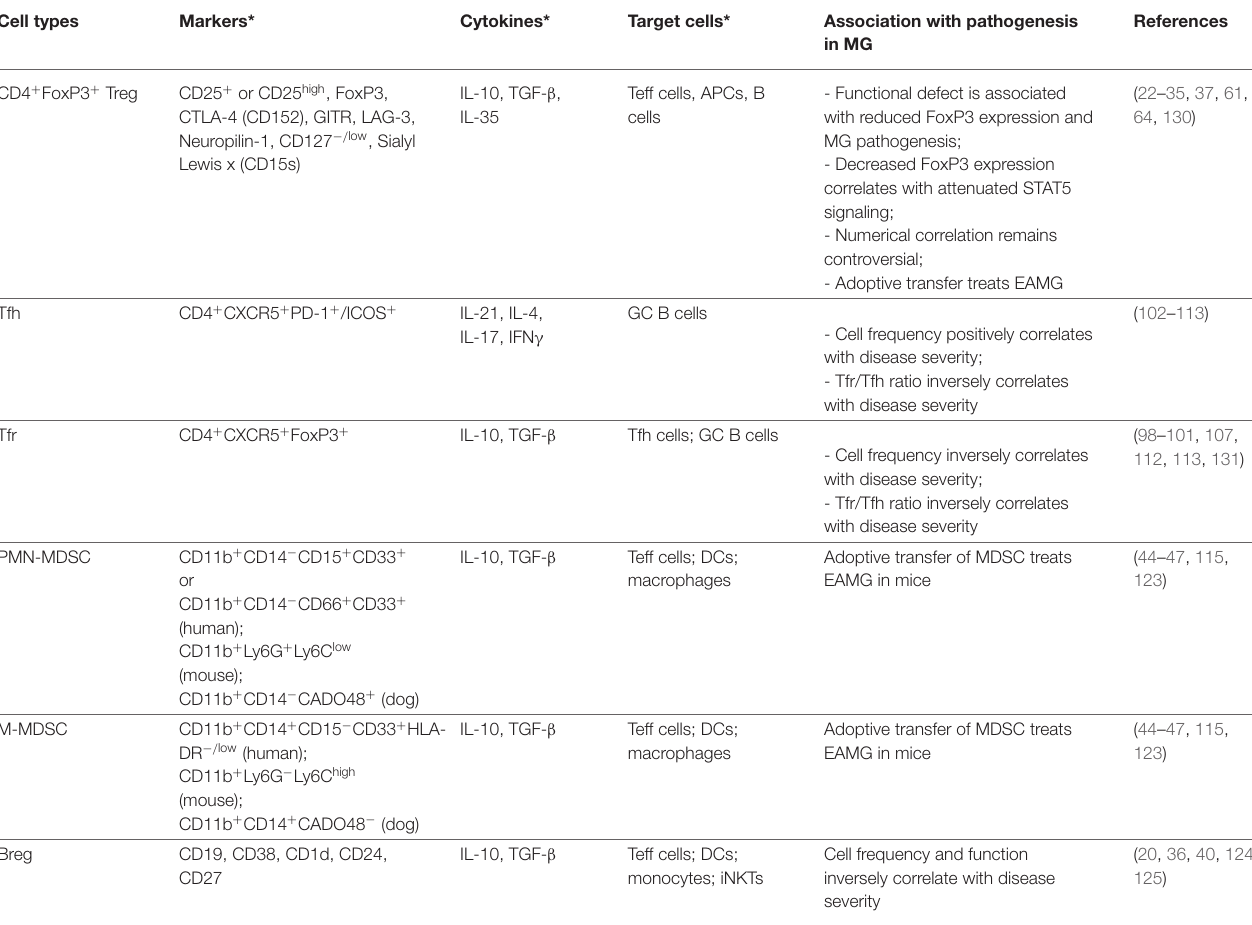
TABLE 1 | Summary of Immunoregulatory Cells in AChR +